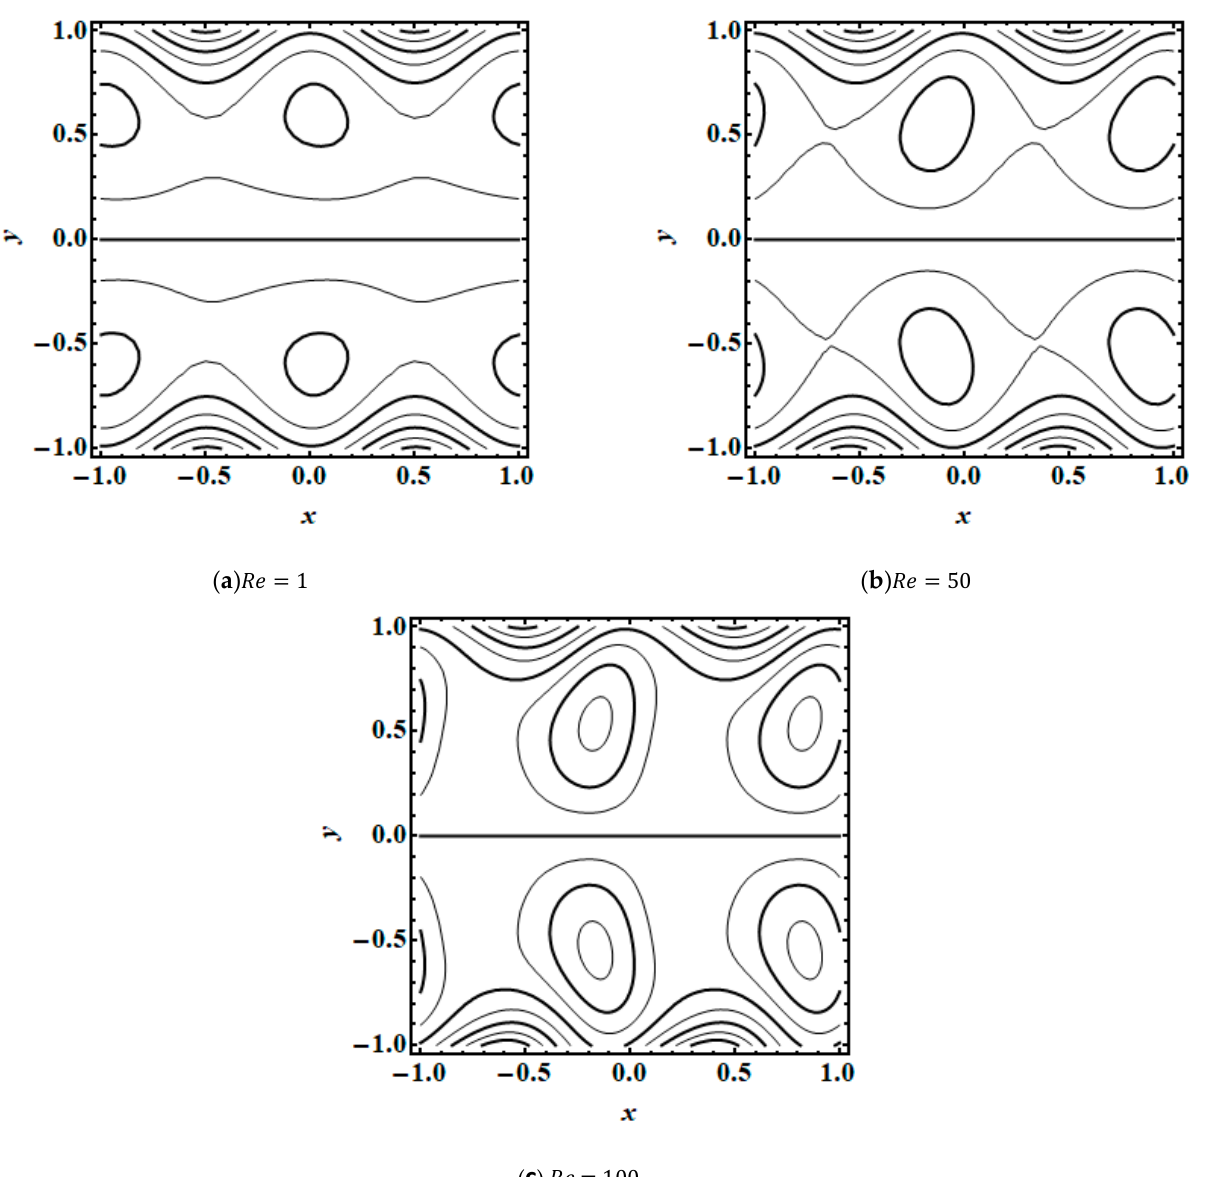
Figure 9. Influence of the Reynolds number Re on the streamline patterns for α = 0.4, β = 0.4, ε = 0.1, Q = 1.5, M = 1, 𝐾 = 0.1, λ (cid:2869) = 0.1.